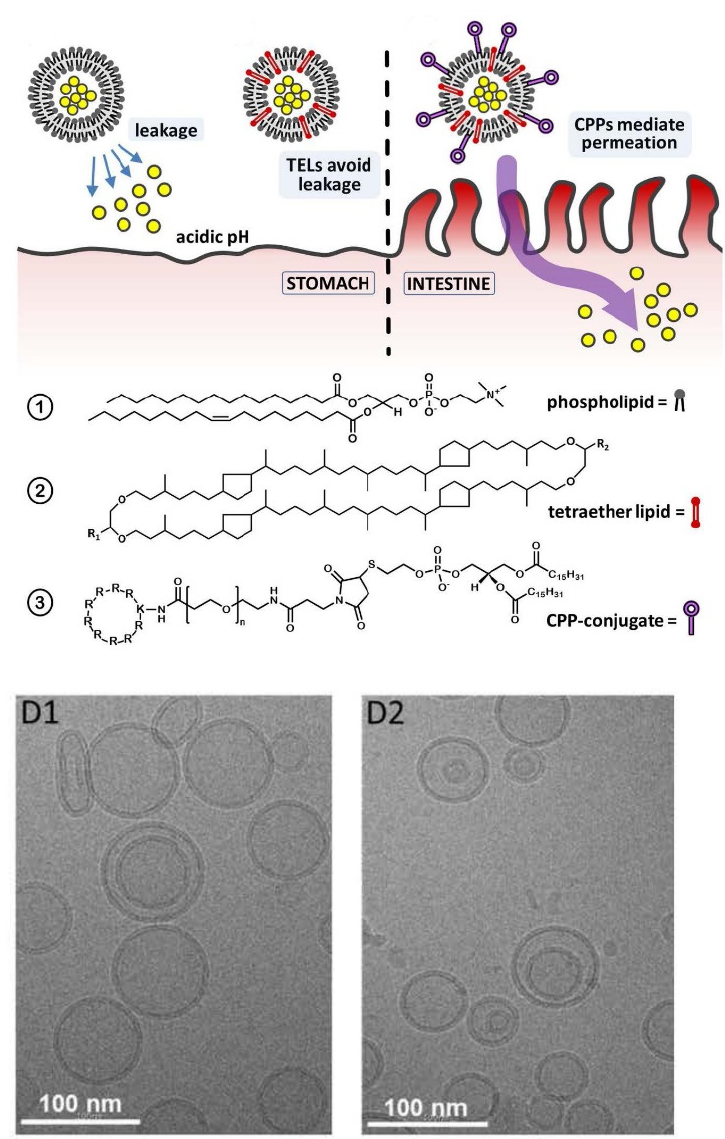
Figure 32. Application of lipid vesicles for oral drug delivery. Top : Illustration of the challenges and concept of the work published by Uhl et al. (2021) [453], for the oral delivery of vancomycin (filled yellow circles) entrapped inside lipid vesicles. Top left : Limitations of the use of conventional liposomes due to chemical instability at the acidic conditions of the stomach, which results in undesired drug release. Top, center : Increased vesicle membrane stability in the presence of bipolar tetraether lipids (TELs). Top right : Increased permeation across the mucosal layer of the small intestine due to the use of lipids carrying a cyclic cell penetrating peptide (CPP) in the polar head group. Middle : Chemical structures of the lipids used in addition to cholesterol. The phospholipid shown is POPC, a representative for the mixture of egg yolk PC (1) that was used [453]. The TELs are mixtures of glycerylcaldityltetraether lipids (2), isolated from Sulfolobus acidocaldarius . For the polar head group R, see for example Chong et al. (2012) [454]. The lipidic CPP-conjugate is a head group-modified double chain phospholipid with two palmitoyl chains (3). The following molar ratio was used: phospholipid (1): cholesterol:bipolar tetraether lipid (2): CPP-conjugate (3) = 84:10:5:1 [453]. Bottom : Cryo-TEM image of the CPP-modified vesicles (D1) and of “control vesicles” consisting of (1) and cholesterol (9:1, mol ratio) only (D2) (bar: 100 nm). The vesicles were prepared by the dual asymmetric centrifugation method [456,457]. Reproduced with permission from [453], Wiley-VCH, GmbH, 2021.